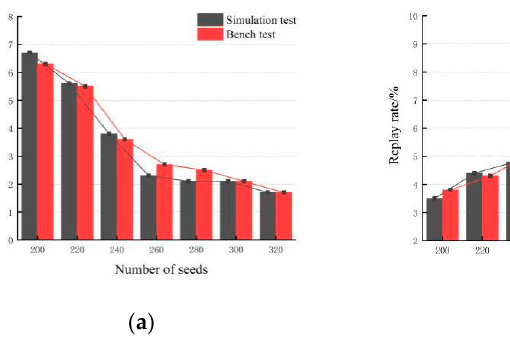
Figure 17. Simulation and experiment variation tendency of seeding process. ( a ) Missing rate; ( b ) replay rate; ( c ) single-seed qualified